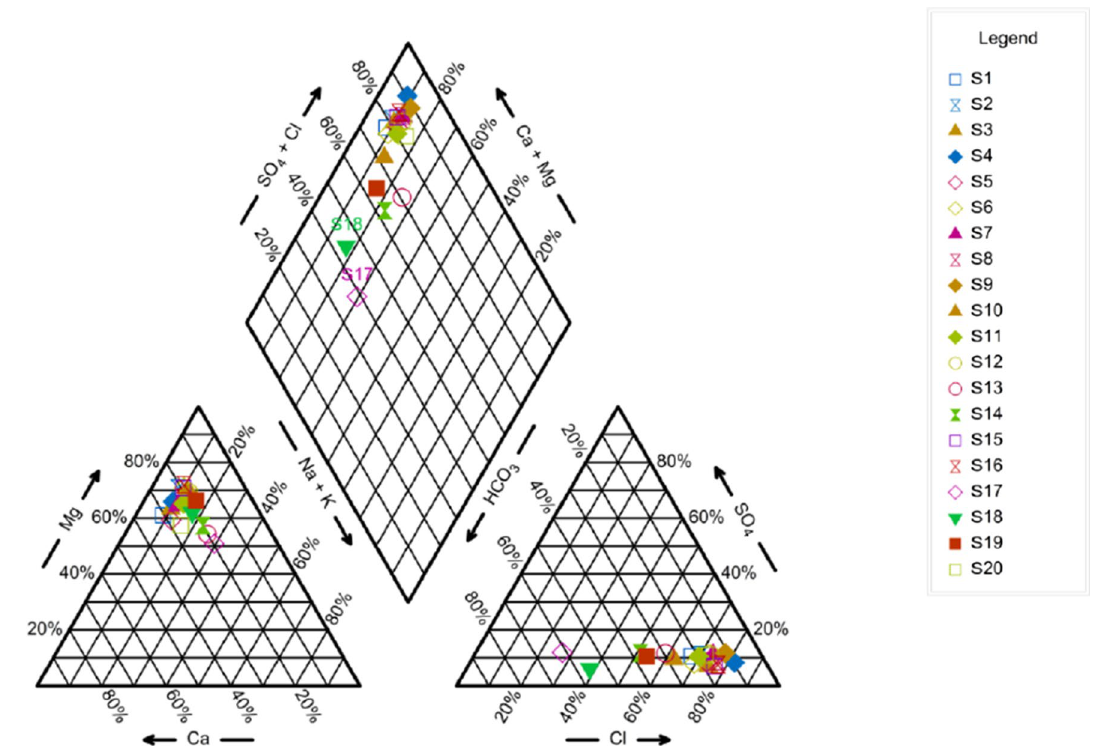
Fig. 6 Piper diagram showing groundwater quality for the study area